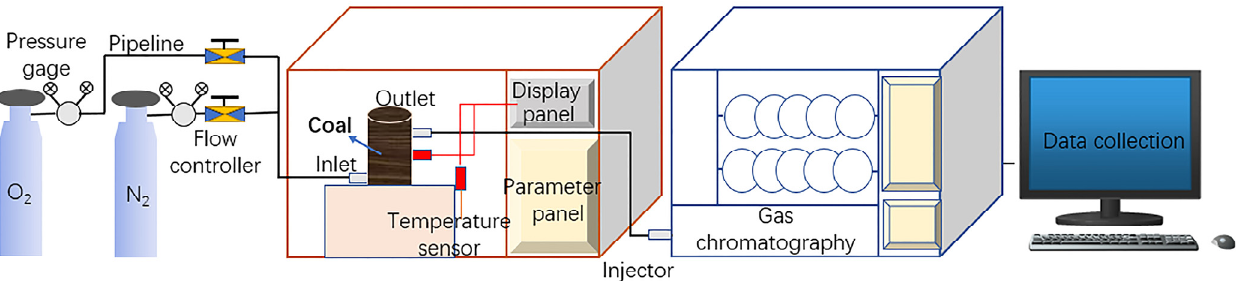
Figure 3. Programmed heating device.